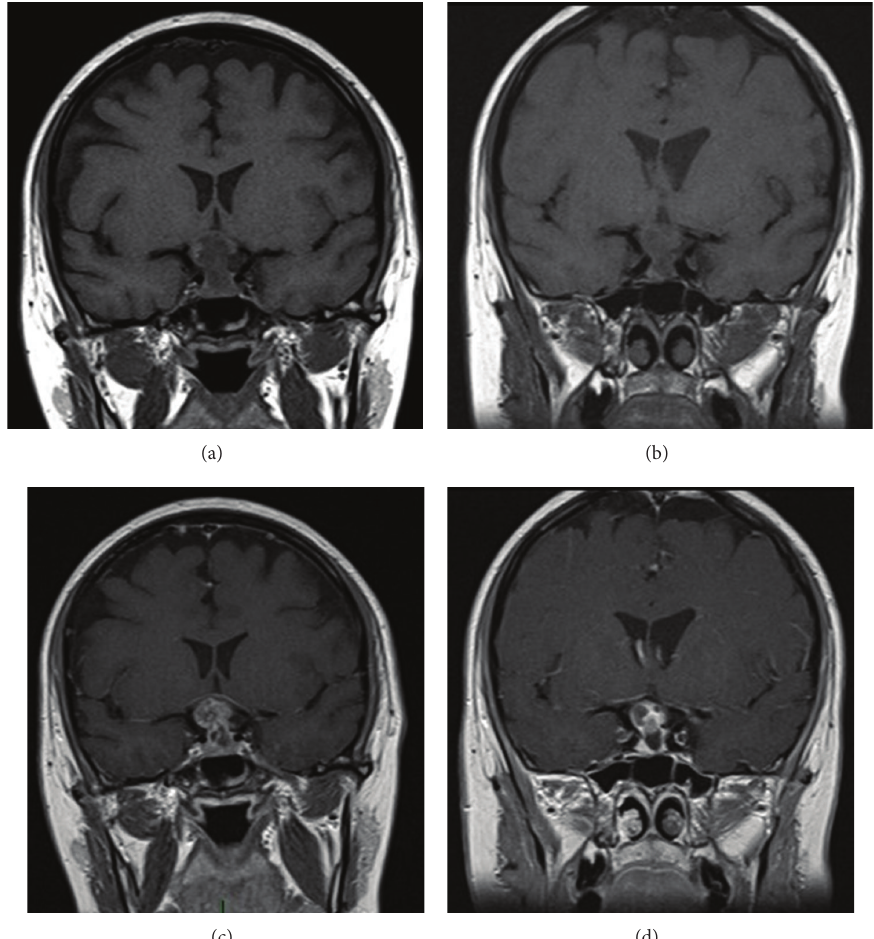
Figure 2: Coronal preoperative ((a) without gadolinium; (c) with gadolinium) and postoperative ((b) without gadolinium ; (d) with gadolinium) T1